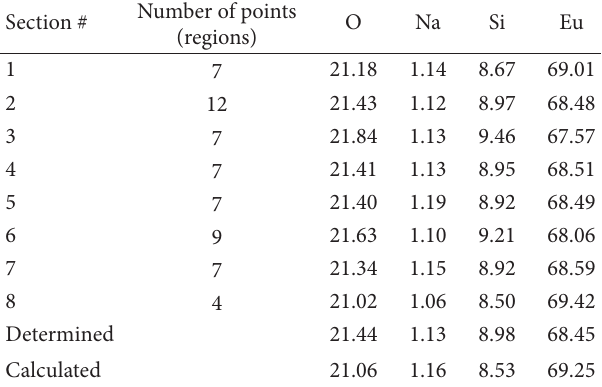
(SiO ) O ( by 9 4 6 2 %